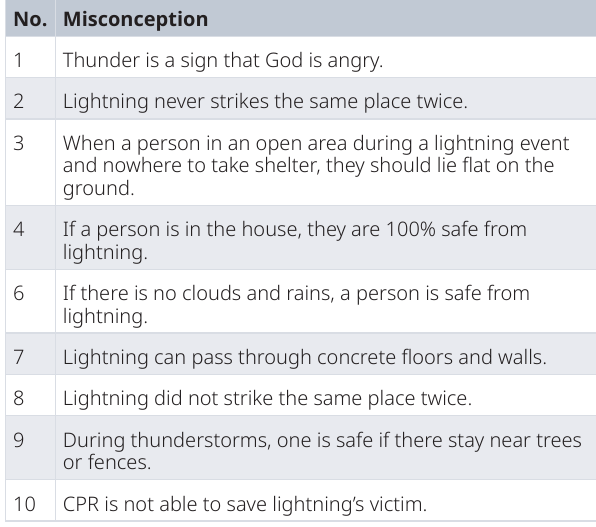
Table 6. Summary of misconceptions.